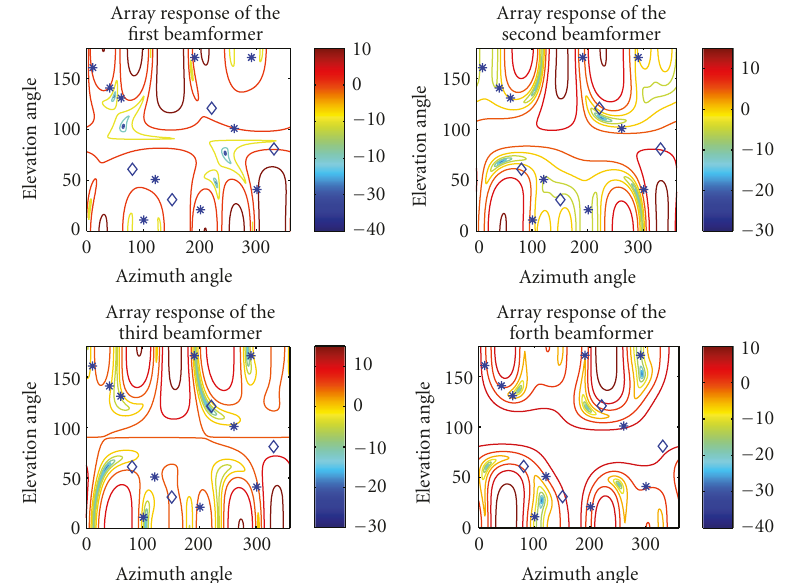
Figure 8: Array response of the adaptive multiple MVDR beamformers with ten vertically polarized jammers. Table 2: Jammer cancellation data and BER for beamfomers 1and